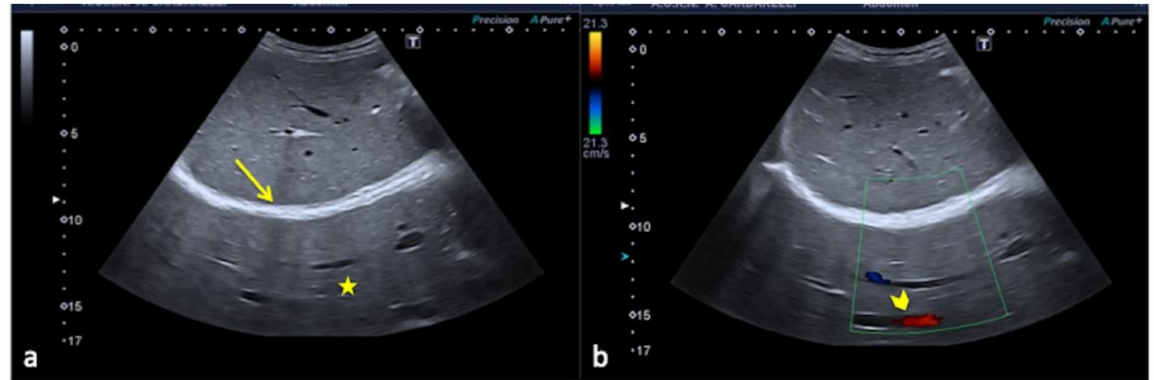
Figure 4. Oblique US image obtained at the level of the right hepatic lobe shows a solid-appearing structure posterior to the diaphragm ( a , arrow) mimicking lung consolidation ( a , star). The presence of a duplicated image of the hepatic vein ( b , arrowhead) makes clear this is an artifact and not a real consolidation.